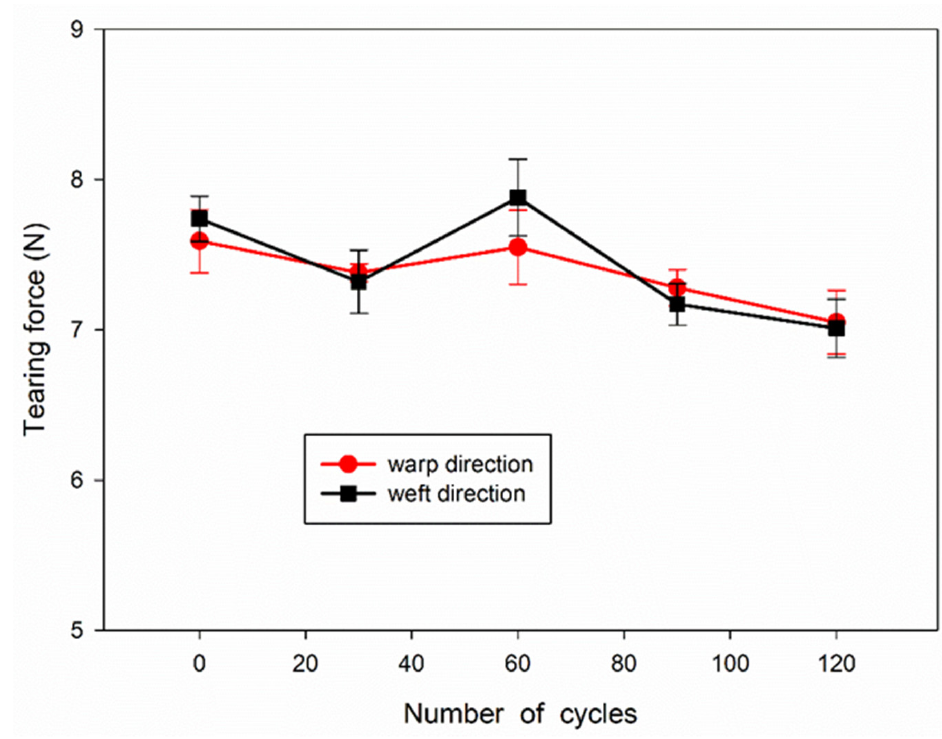
Figure 4. Dependence of tearing force on number of disinfection and washing cycles of cotton fabric.